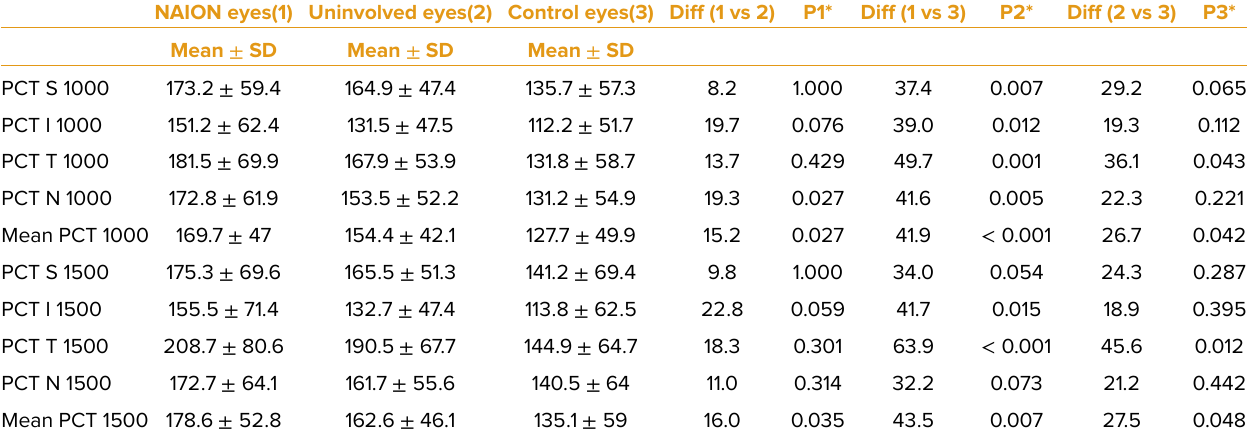
Table 3. Measurements of PCT in different areas in NAION, uninvolved and control eyes